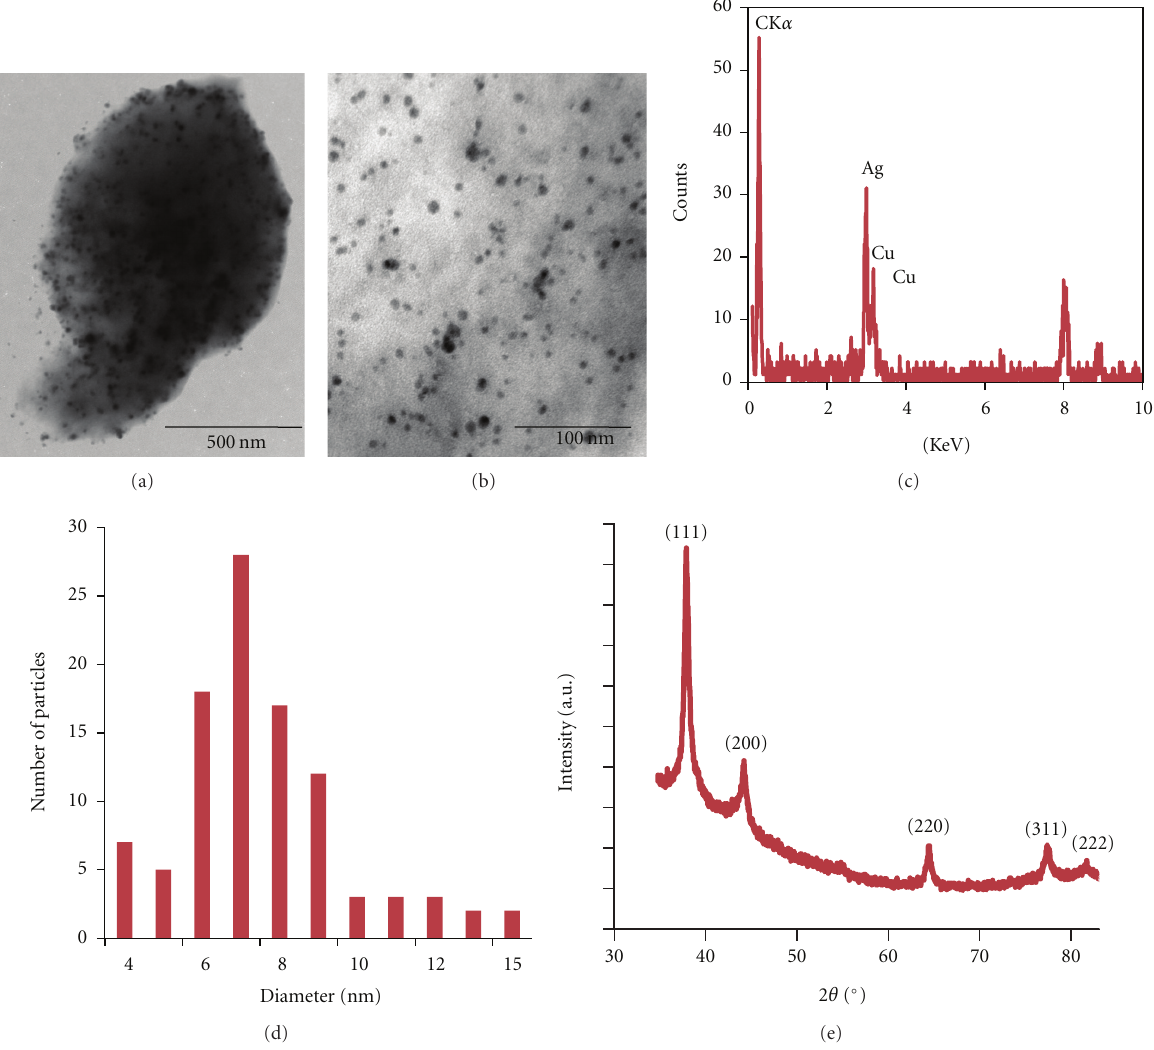
Figure 3: TEM micrographs recorded on a drop-coated film with yeast biomass/AgNPs aqueous suspension, after 24h (a). EDX spectra (b) and particle size distribution histogram determined from the TEM micrographs (c). XRD pattern recorded from the thin film prepared by drop coating the biomass/AgNPs aqueous suspension after 24 h on a Si wafer; the principal Bragg reflections are identified